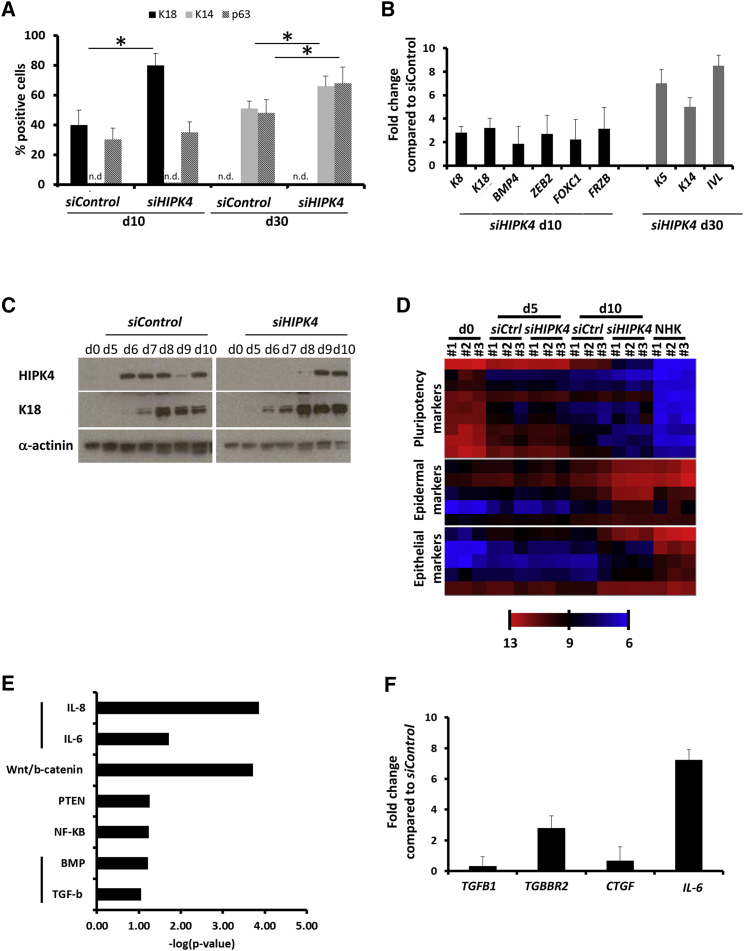
Validation of HIPK4 as an Inhibitor of Skin Epithelial Differentiation(A) Immunofluorescence staining against K18, K14, and p63 at day 10 and day 30 of differentiation in control condition and under HIPK4 knockdown. Histogram represents the percentage of positive cells. Data represent a mean of three independent experiments ± SEM. Statistical analysis was performed using unpaired Student's t test (∗p < 0.05). n.d., not detected.(B) qPCR analysis of epithelial markers under HIPK4 knockdown at day 10 (black bars) and keratinocyte makers under HIPK4 knockdown at day 30 (gray bars). Values represent fold changes compared with the respective controls and are mean of three independent experiments ± SEM.(C) Western blot analysis of HIPK4 and K18 expression in the indicated conditions.(D) Heatmap representing a hierarchical gene clustering of pluripotency, epidermal, and epithelial markers generated from hiPSCs (d0), normal human keratinocytes (NHK), and day 5 (d5) and day 10 (d10) of differentiation with or without HIPK4 knockdown. Color code represents log2-expression values.(E) Ingenuity Pathway Analysis showing some of the top regulated signaling pathways after HIPK4 knockdown at day 10 of differentiation (compared with siControl).(F) qPCR analysis of IL-6 and three members of the TGF-β signaling (TGFB1, TGFBR2, and CTGF) under HIPK4 knockdown at day 10. Data represent a mean of three independent experiments ± SEM.